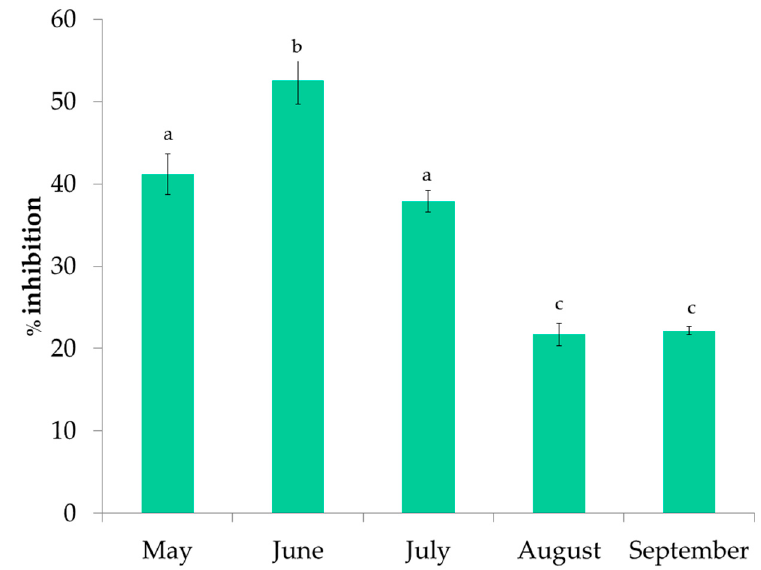
Figure 5. DPPH inhibition results for extracts of P. pavonica harvested from May to September. a–c different letters denote statistically significant difference.